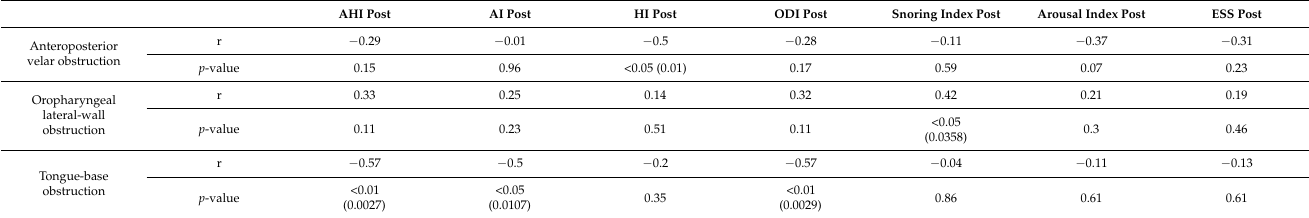
Table 3. Spearman’s rho (r) correlation coefficients for DISE findings with various postoperative PSG metrics and ESS score.